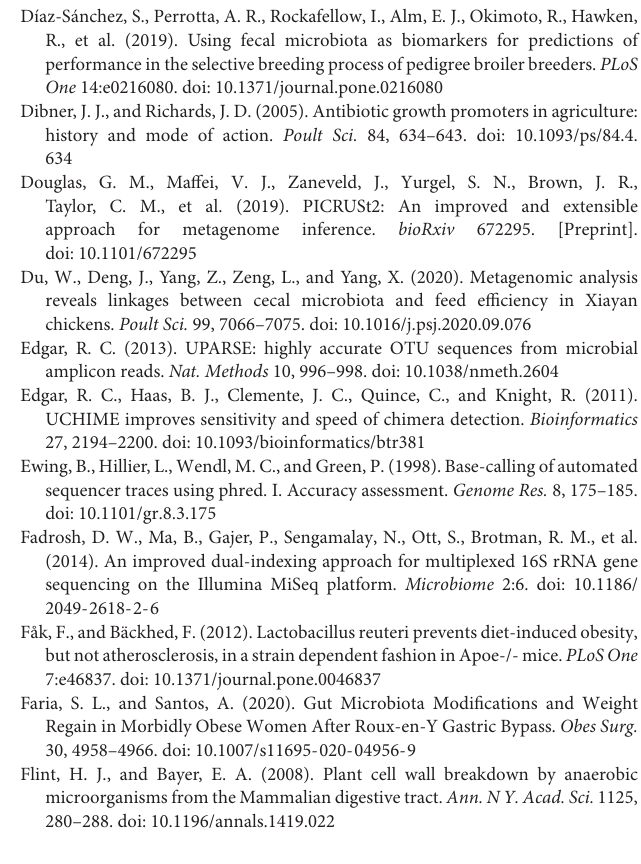
Supplementary Figure 1 | Distribution of feed conversion ratio (FCR) value for each sample (A) and boxplot of FCR values in HFE and LFE groups (B) . HFE and LFE, high and low feed efficiency; NS, unselected samples; ∗∗∗ P < 0.001. Supplementary Figure 2 | Venn diagram of operational taxonomic units distribution in each group (A) and rarefaction curve for each sample (B) . Hdu and Ldu : high and low feed efficiency groups in the duodenum; Hil and Lil, high and low feed efficiency groups in the ileum. Supplementary Table 1 | Ingredients and nutrient composition of the feed used. Supplementary Table 2 | Difference analysis of relative abundance at phylum and genus levels of part of the microbes in the duodenum and ileum of HFE and LFE groups. Supplementary Table 3 | Statistics of Alpha diversity index of duodenal and ileal